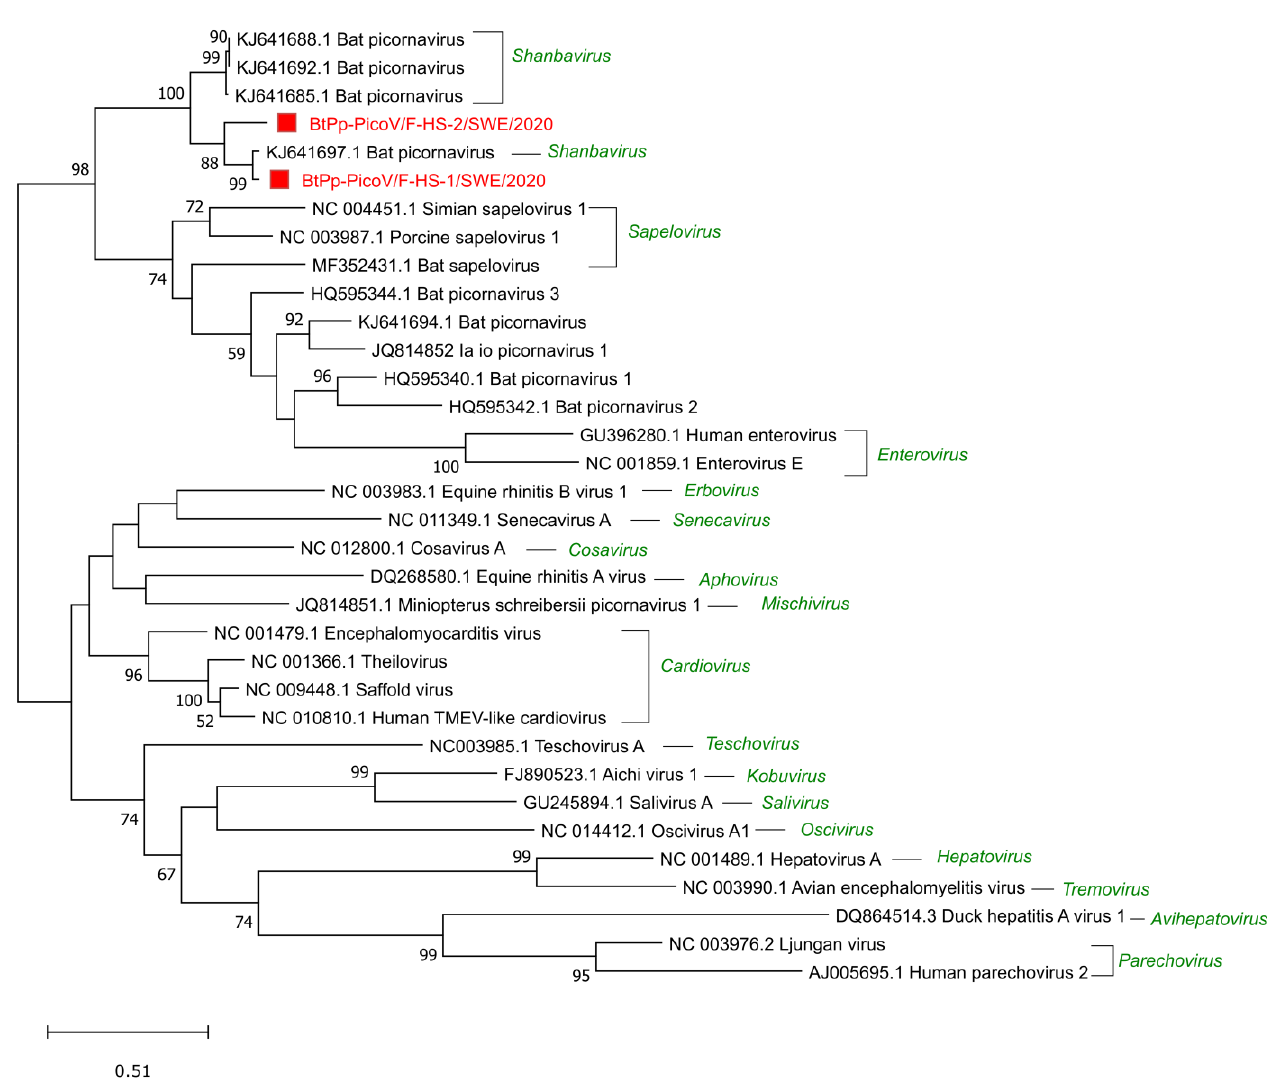
Figure 4. Phylogenetic analysis of bat picornaviruses from Sweden based on the conserved capsid protein. The sequences reported in this study, BtPp-PicoV/F-HS1/SWE/2020 (ON375332) and BtPp-PicoV/F-HS2/SWE/2020 (ON375333) (indicated by red square boxes and red text), the closest sequence matches from Genbank and ICTV reference sequences from a different genus within the Picornaviridae family (indicated in green) are included in the analysis. The tree was generated using MEGAx and a maximum likelihood model with 500 bootstrap iterations on ClustalW aligned amino acid sequences, with a total length of 256 amino acids. Only bootstrap values above 50 are displayed on the nodes.